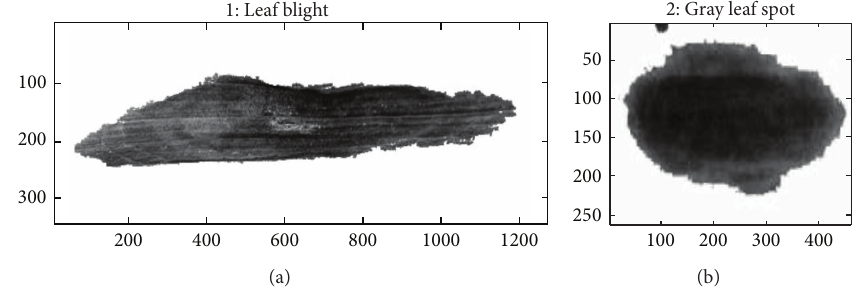
Figure 10: Leaf blight and Gray leaf spot segmentation results.